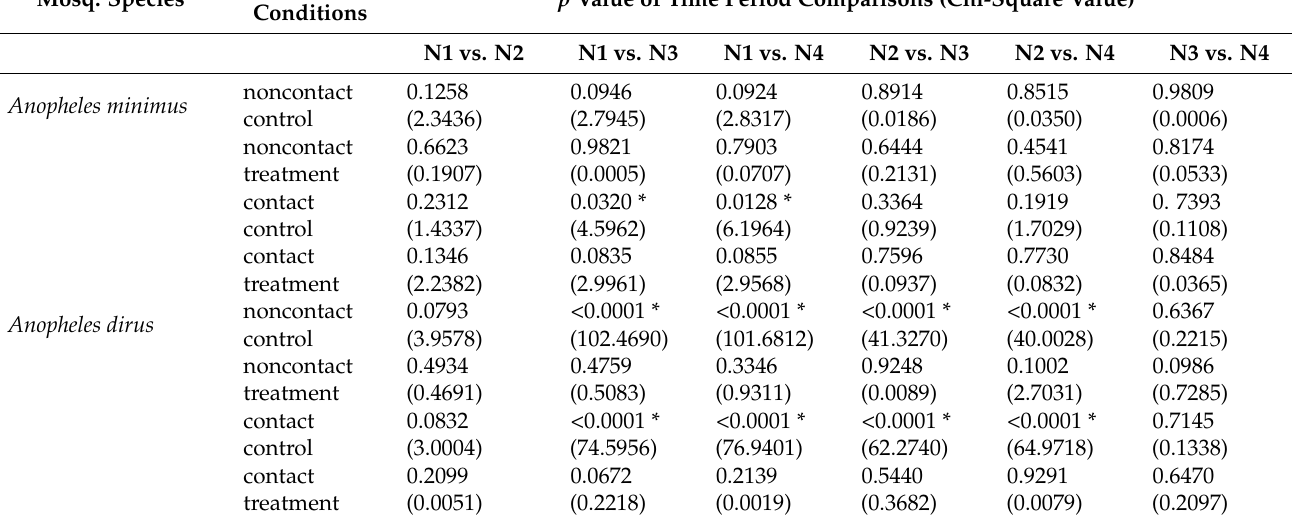
Table 5. Log-rank tests comparing diel quarterly time periods in nighttime within species and treatments for Anopheles minimus and Anopheles dirus